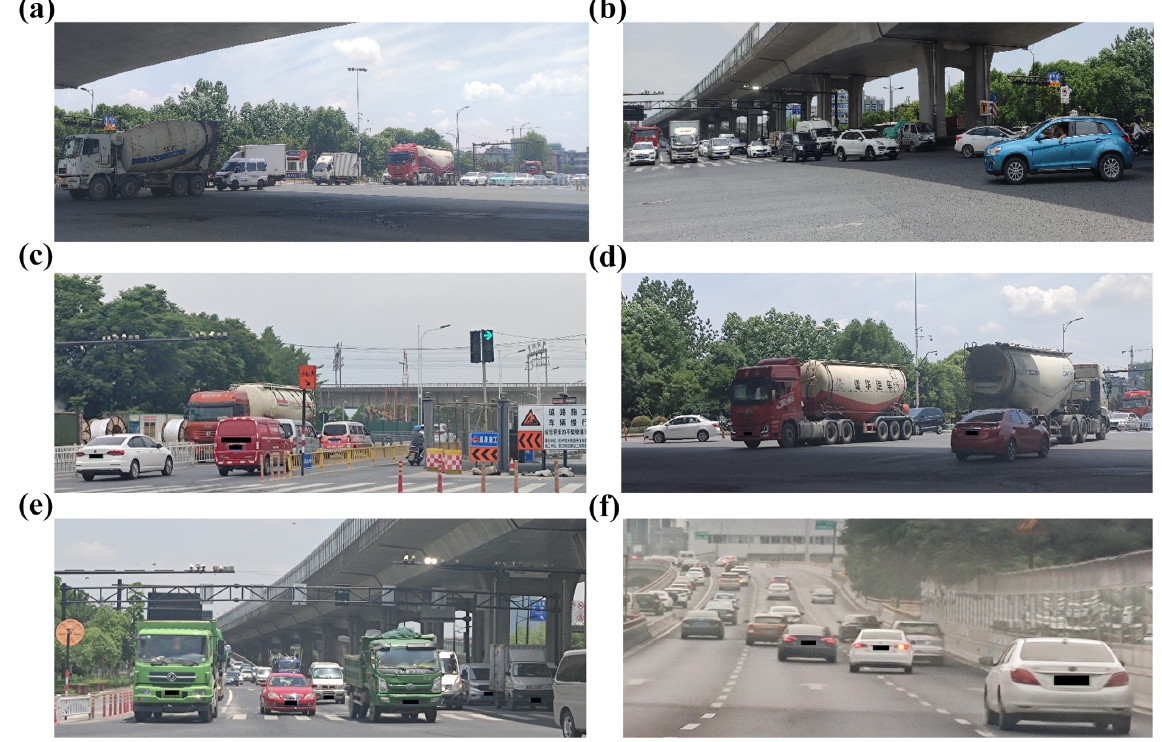
Figure 4. Imagery analysis for illustrative traffic hotspots. (a, b) Over the hotspots in the urban zones, frequent large traffic fluxes are identified on major arterial roads and their intersections. (c) Constructions in the middle of the roads also lead to traffic congestion. (d, e) Morning and afternoon traffic rushes further exacerbate traffic congestion. (f) Over the highways, the hotspots are related to large traffic fluxes of MDTs and HDTs. The vehicle license plates are pixelated. The hotspot locations are presented in Fig.